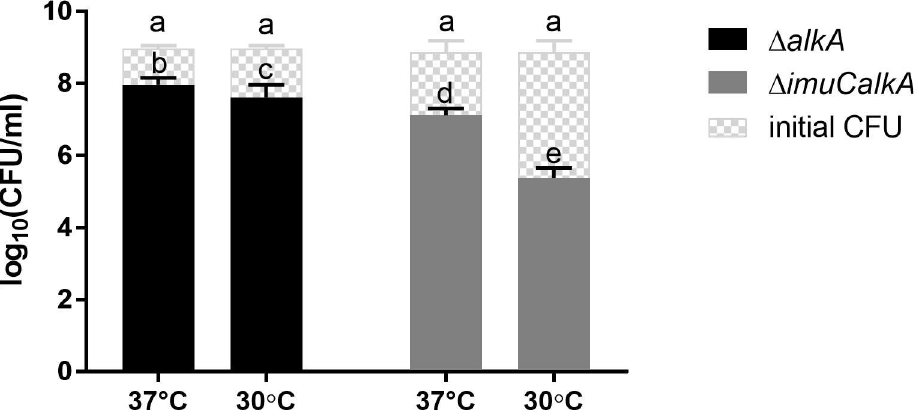
Fig 10. Effect of incubation temperature on the survival of MMS-treated alkA -deficient bacteria. The survival of P . aeruginosa Δ alkA (black) and Δ imuCalkA (grey) strains at 37˚C or 30˚C after treatment with 2.5 mM MMS for 45-min periodis indicated. Data representsthe mean ( ± SD)values. Columns with the pattern fill representthe initial CFU/ml. Letters indicatehomogeneous groups accordingto ANOVA followedby Bonferroni’s multiplecomparisons test ( P <